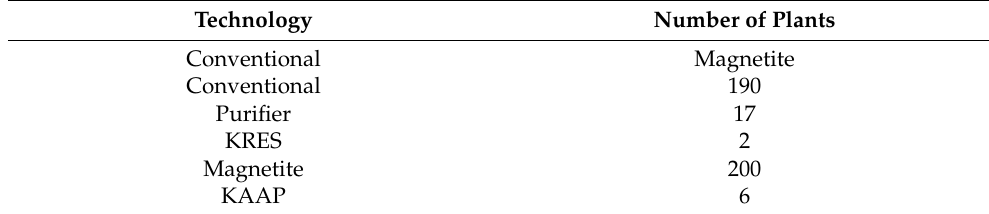
Table 3. KBR design experience with technology